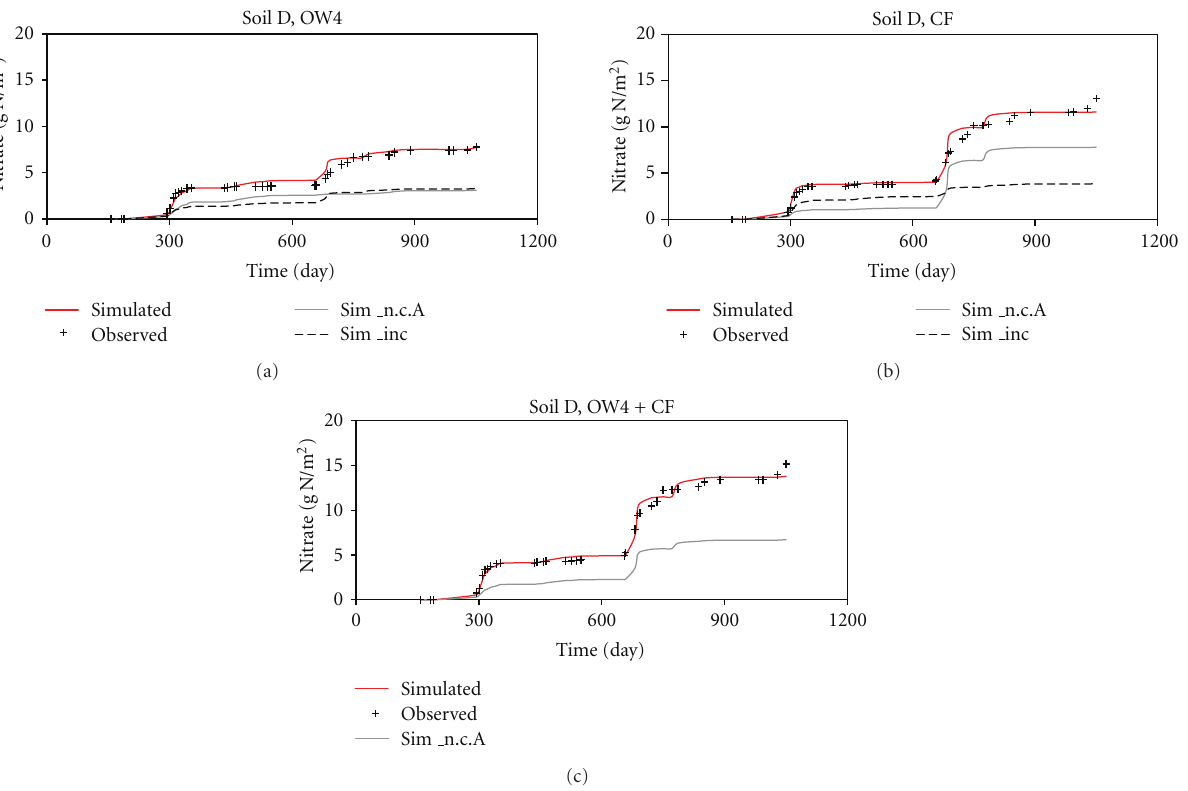
Figure 6: Application of organic matter to soil D. Simulated and observed NO 3 − -N leaching [gNm − 2 ] (accumulated values). Broken line indicates simulation with no calibration of management routine